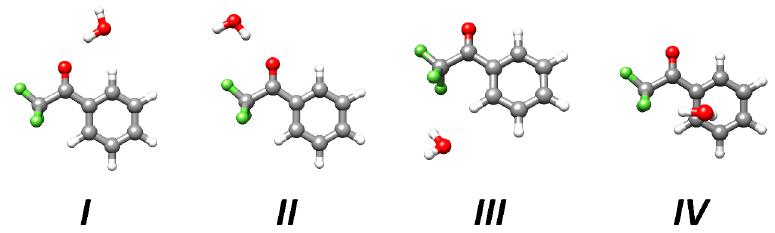
Figure 1. Molecular structures of the low-energy isomers (numbered according to the relative stability) of the TFAP-W complex issuing from rDSDjun computations. Table 1. Equilibrium rotational constants (MHz) 1 , electric dipole moment components (debye) 2 , relative equilibrium 3 and zero-point corrected 4 energies (kJ · mol − 1 ), equilibrium dissociation